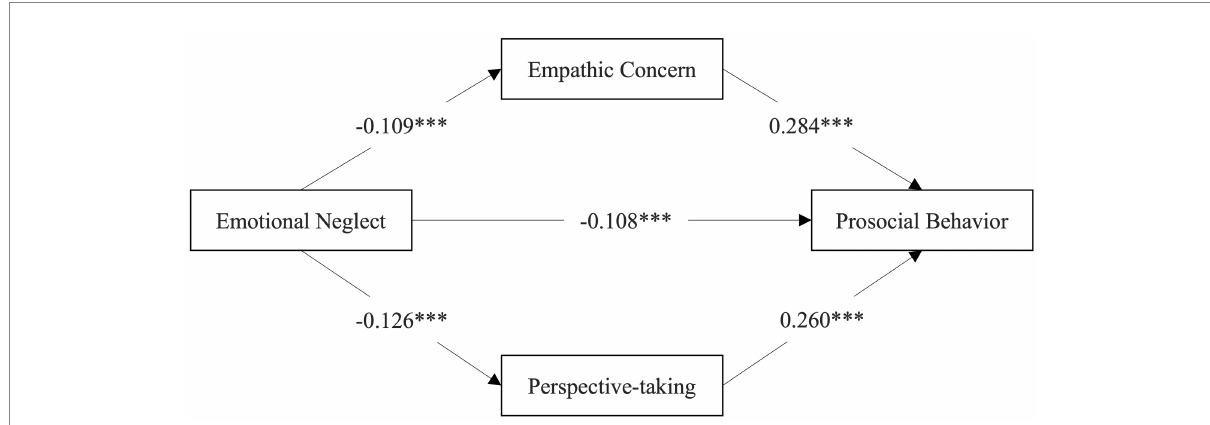
FIGURE 2 Empathic concern and perspective-taking mediate the association between emotional neglect and prosocial behavior. *** p